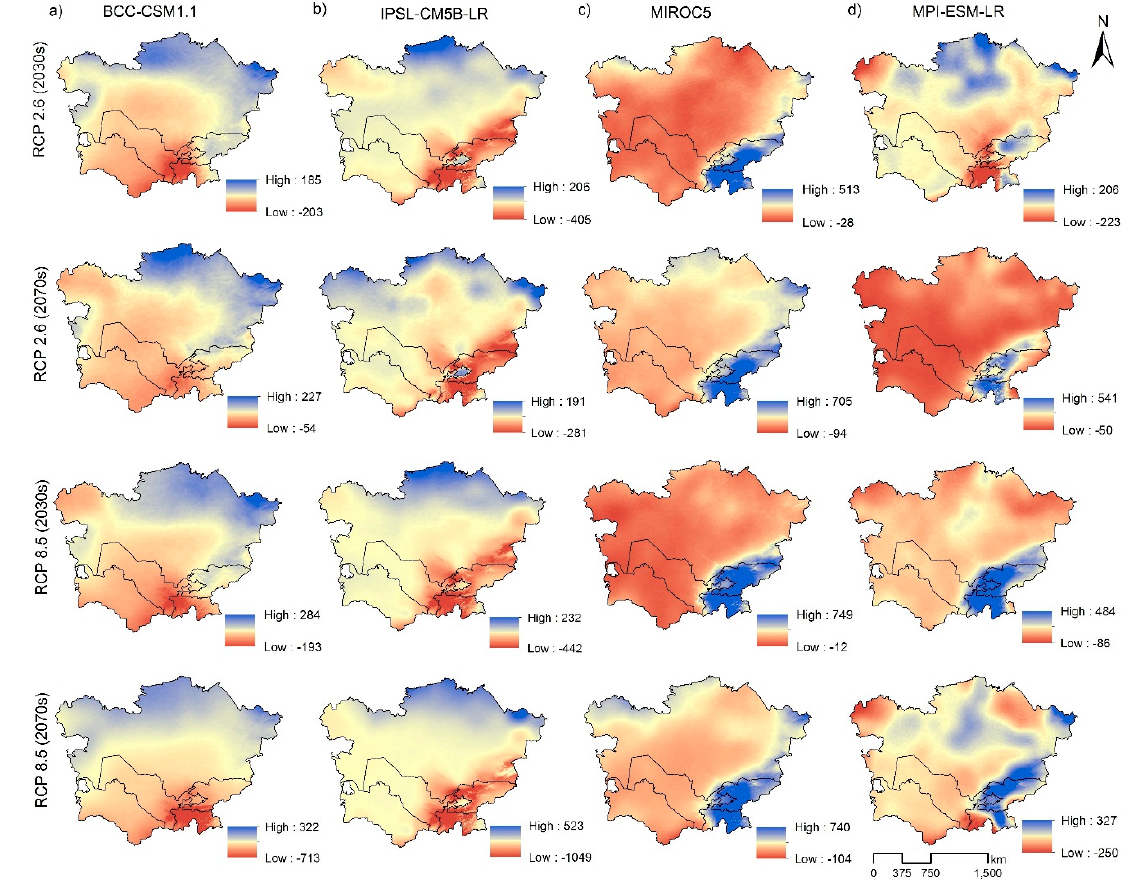
Figure 6. Absolute differences of rainfall erosivity ( MJ mm ha − 1 h − 1 year − 1 ) between 2030, 2070 projections and baseline data.